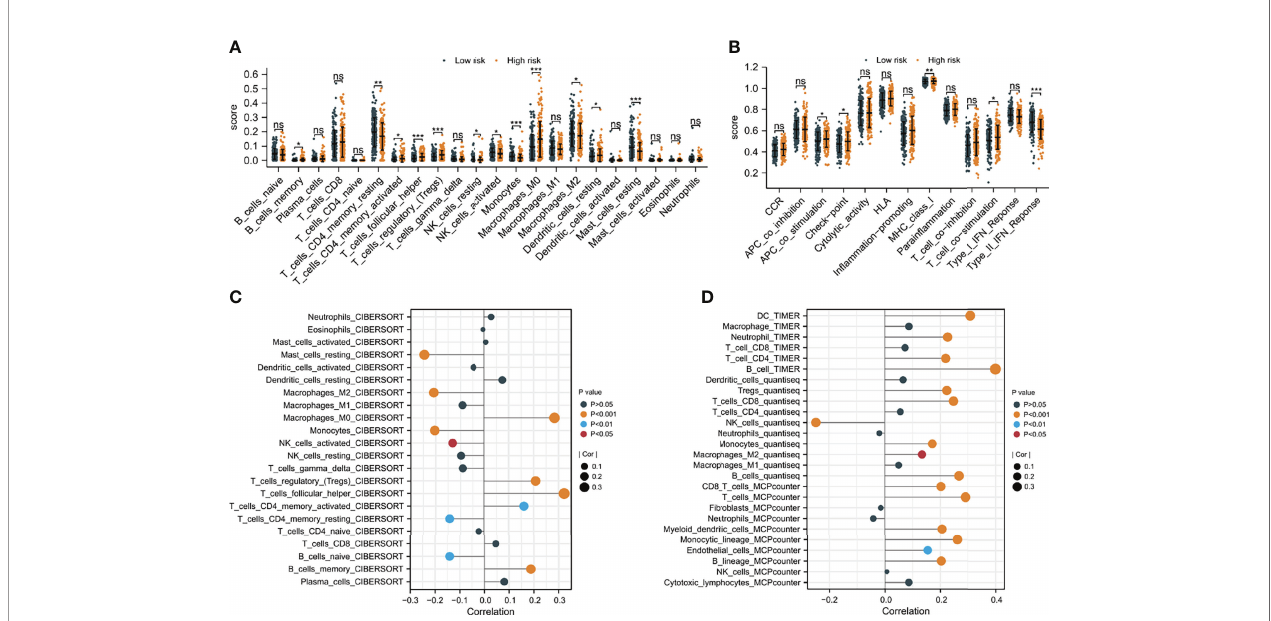
FIGURE 8 | The difference in immune in fi ltration characteristics of tumor microenvironment between low and high risk groups. (A) Immune cell in fi ltration analysis (B) immune-related pathways in fi ltration analysis (C, D) the correlation analysis of immune cells by various algorithms statistical signi fi cance is indicated by the following symbols: ns, p ≥ 0.05; *, p < 0.05; **, p < 0.01; ***, p <